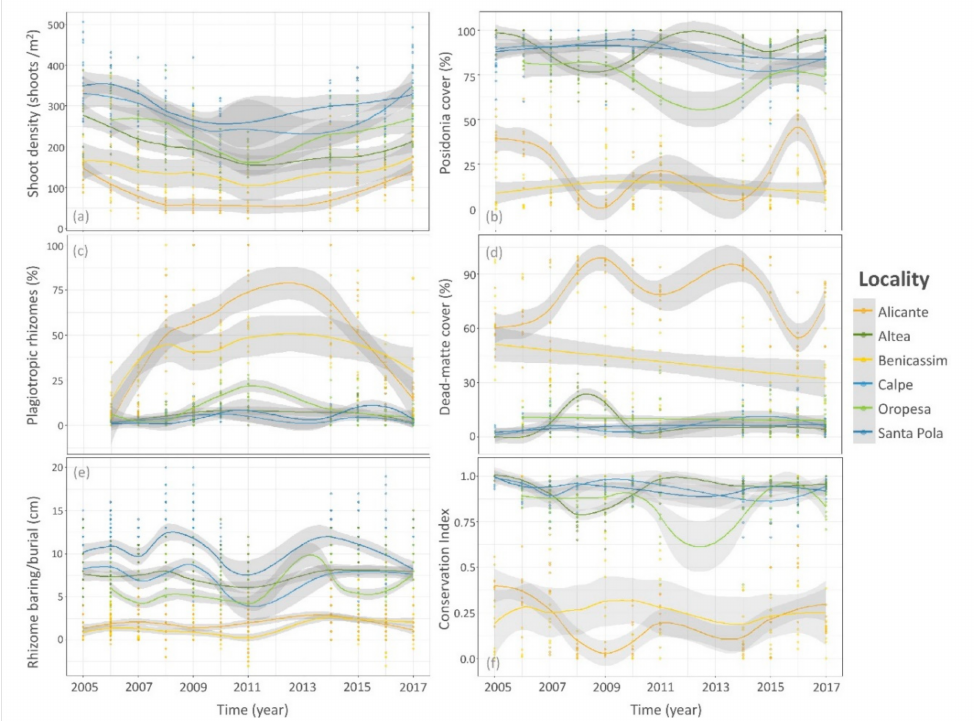
Figure 4. Temporal trends in ( a ) Shoot density, ( b ) Posidonia cover, ( c ) Plagiotropic rhizomes, ( d ) Dead-matte cover, ( e ) Rhizome baring / burial and ( f ) Conservation Index. Di ff erent colors indicate differentlocalityandmeadowconservationquality(bluish = high,greenish = good,yellow-orange = poor). The shaded bands surrounding the estimated trends represent 95% confidence